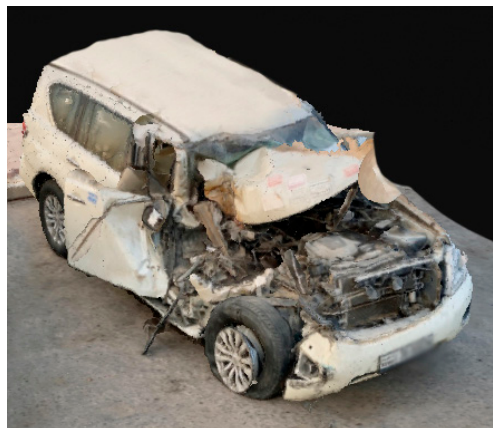
Figure 8. Photogrammetrically reconstructed 3D model of a real collided vehicle in Kuwait in the Alrabiya area.